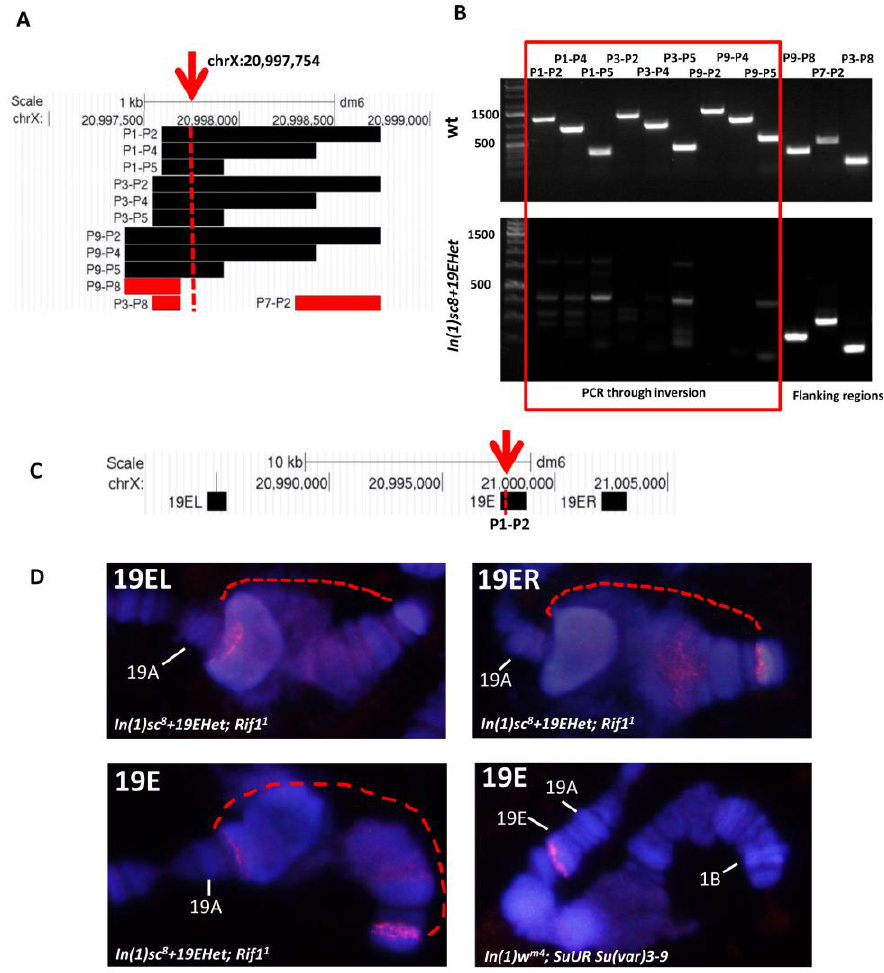
Figure 3. Elicitation of inversion breakpoints using nanopore sequencing. ( A ) Genome Browser view of the distal In(1)sc 8 breakpoint (blue line, chrX:382,384 – 382,389 ). Positions of two regions ( chrX: 381,979 – 382,378 and chrX: 382,391 – 382,719 ) used for extraction of nanopore reads are shown at the top. Soft-clipped aligned reads, overlapping the breakpoint, are shown below. The position and feature maps of the two longest reads overlapping the In(1)sc 8 breakpoint are shown below the alignment. In both cases, long (>20 kb) stretches of 1.688 satellite (designated as SAR_DM and SAR2_DM according to RepeatMasker) were detected beyond the breakpoint position. Parts of the chimeric reads corresponding to euchromatin sequence immediately near the breakpoint are marked in black. Other colors demark different types of repeats in the fused heterochromatin. ( B ) In(1)19EHet breakpoint in chrX:20,997,754 . Overall arrangement of the image is the same as for A. ( C ) Schematic representation of repetitive sequences flanking In(1)sc 8 and In(1)19EHet breakpoints. Transposable elements are designated according to RepeatMasker. ( D ) The chrX:20,997,754 breakpoint position relative to the intercalary heterochromatin polytene chromosome double band 19E1 – 4 and nearest gene positions.